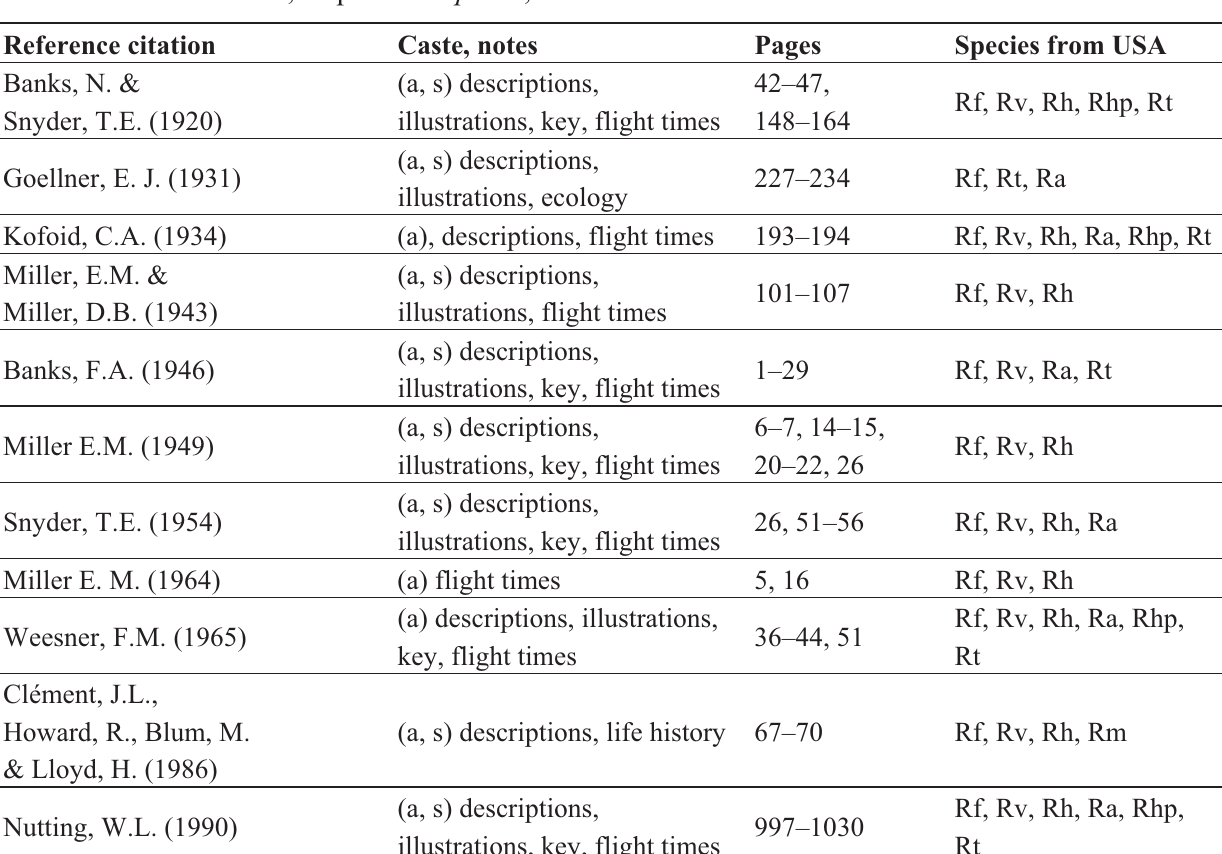
Table 1. Summary of taxonomic literature that provide morphology and life history information on Reticulitermes spp. found in the southeastern United States, parenthetical letters are defined as follows: a = alate, s = soldier, species abbreviations are defined as follows: Rf = R. flavipes , Rv = R. virginicus , Rh = R. hageni , Rm = R. malletei